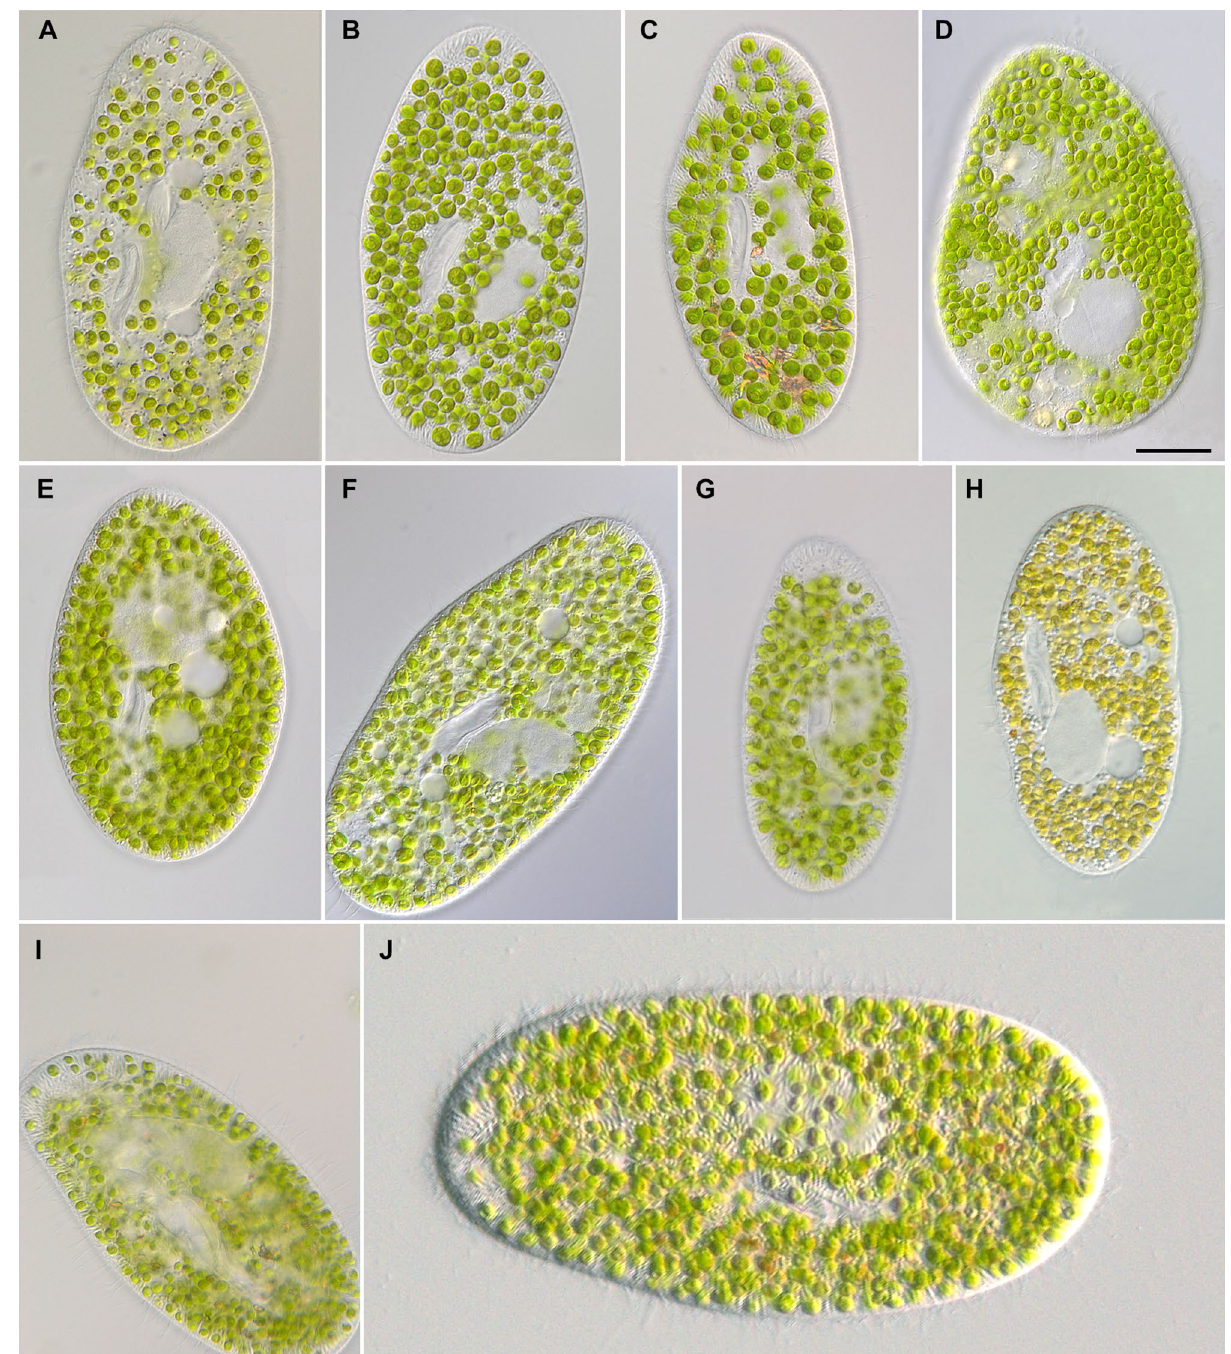
Figure 5. Ventral views of Paramecium bursaria morphotypes in vivo: P. protobursaria (syngen R1), i.e., strains SAG 2645 ( A ) and PB-25 ( B ); P. deuterobursaria (syngen R2), i.e., strains CCAP 1660/36 ( C ) and CCAP